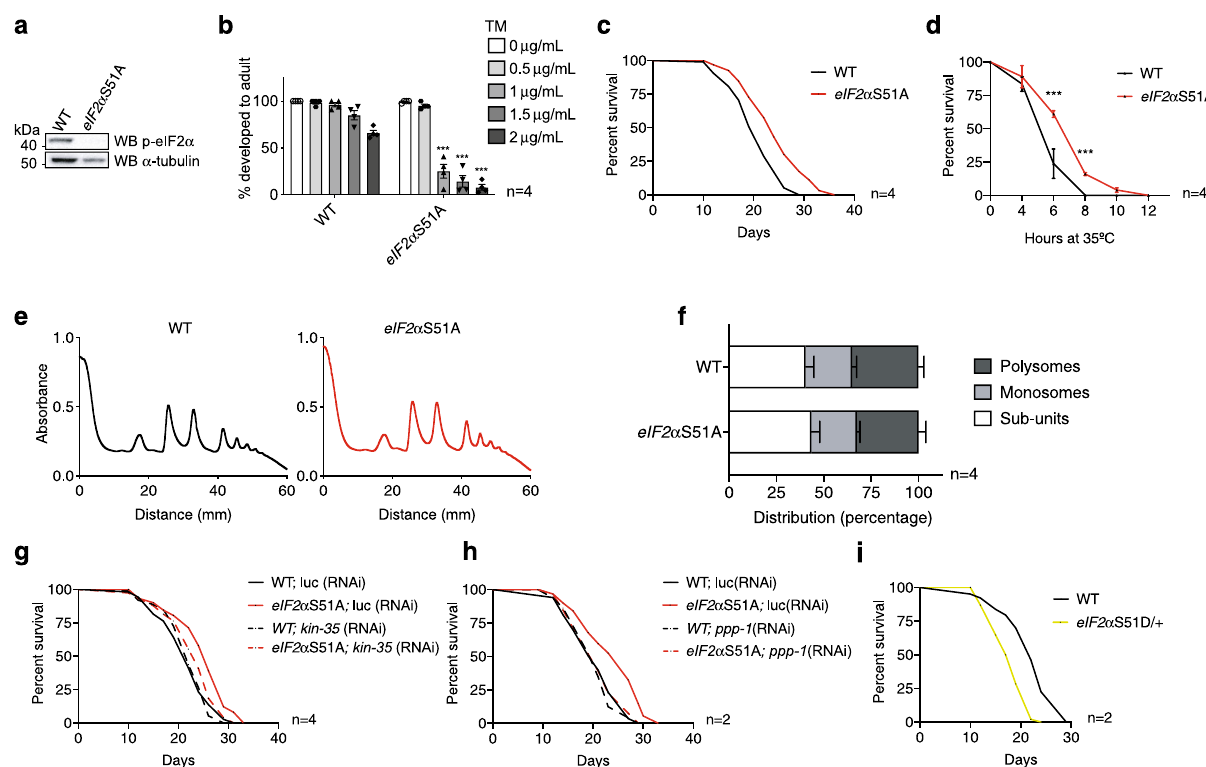
Fig. 6 Direct ISR inhibition through phospho-defective eIF2 α S51A mutations extends lifespan via eIF2B. a Western blot of day 1 WT animals and eIF2 α S51A mutants using anti-phospho-eIF2 α (Ser51) and anti- α -tubulin antibodies. b Developmental tunicamycin (TM) resistance assay of WT animals and eIF2 α S51A mutants treated with tunicamycin at the indicated concentrations (error bars represent means + SEM, two-way ANOVA Sidak ’ s post hoc test, *** p < 0.001 vs. WT at respective tunicamycin concentration; n = 4 independent experiments with ≥ 20 animals each). c Survival of eIF2 α S51A mutants compared to WT control animals (representative data from n = 4 independent experiments). d Thermotolerance assays of eIF2 α S51A mutants compared to WT animals (error bars represent means± SD, two-way ANOVA Sidak ’ s post hoc test with *** p < 0.001 vs. WT controls; n = 4 independent experiments with 50 animals each). e , f Polysome pro fi ling and quanti fi cation of day 1 WT worms and eIF2 α S51A mutants (error bars represent means + SD, two-way ANOVA Dunnett ’ s post hoc test; n = 4 independent experiments). g Survival of WT worms and eIF2 α S51A mutants upon RNAi treatment targeting kin-35 or control luciferase (representative data from n = 4 independent experiments). h Survival of WT animals and eIF2 α S51A mutants upon RNAi treatment targeting ppp-1 or control luciferase (representative data from n = 2 independent experiments). i Survival of heterozygous phospho-mimic eIF2 α S51D/ + mutants compared to WT control animals (representative data from n = 2 independent experiments). See Supplementary Dataset 1 for survival statistics. See Supplementary Table 1 for statistics on thermotolerance assays. Source data are provided as a Source Data fi